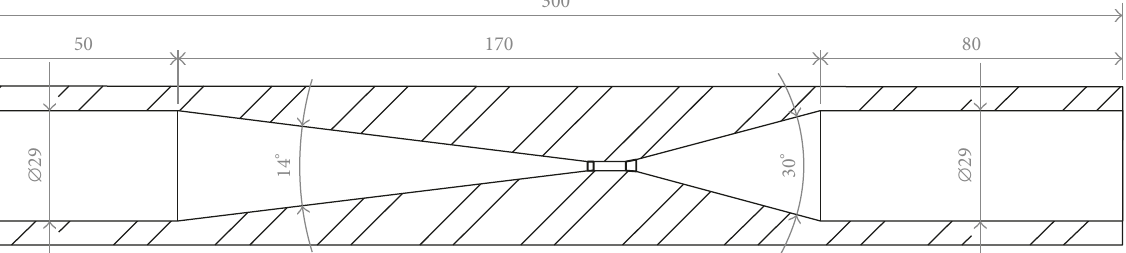
Figure 2: Schematic of the hybrid rocket motor system.